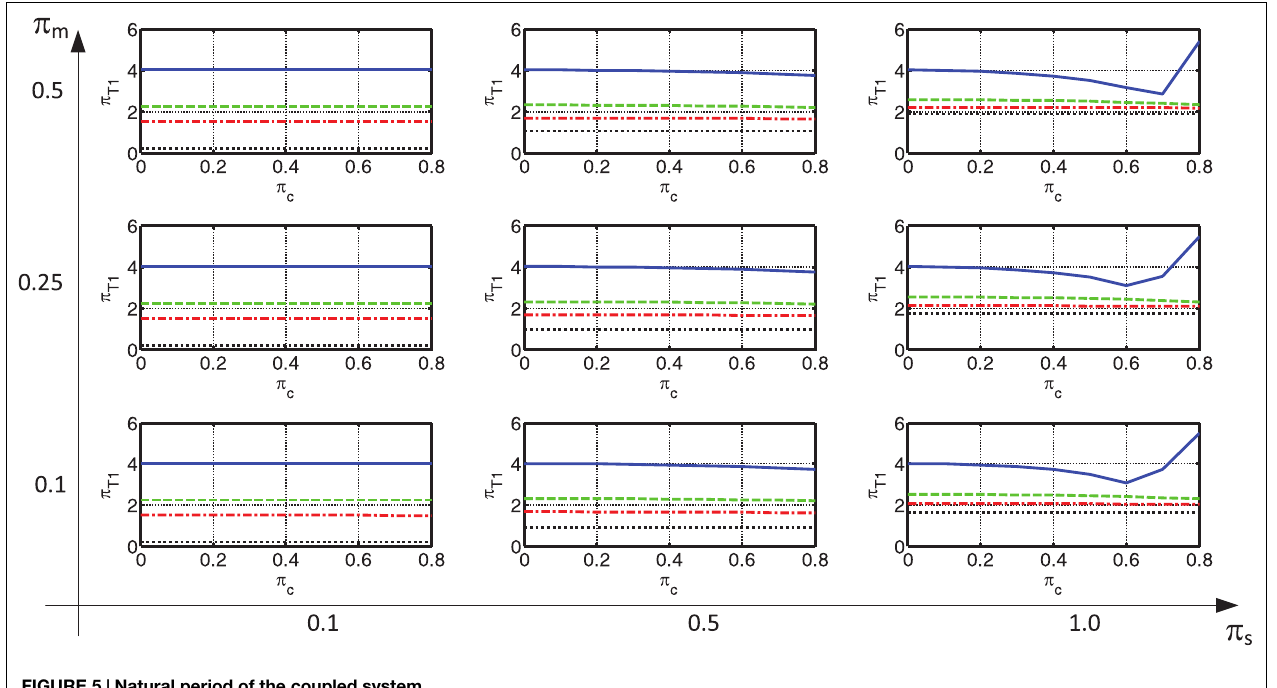
FIGURE 5 | Natural period of the coupled system